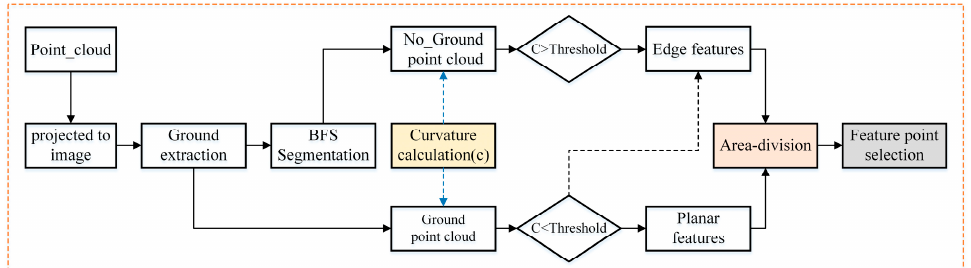
Figure 3. Feature point extraction process.